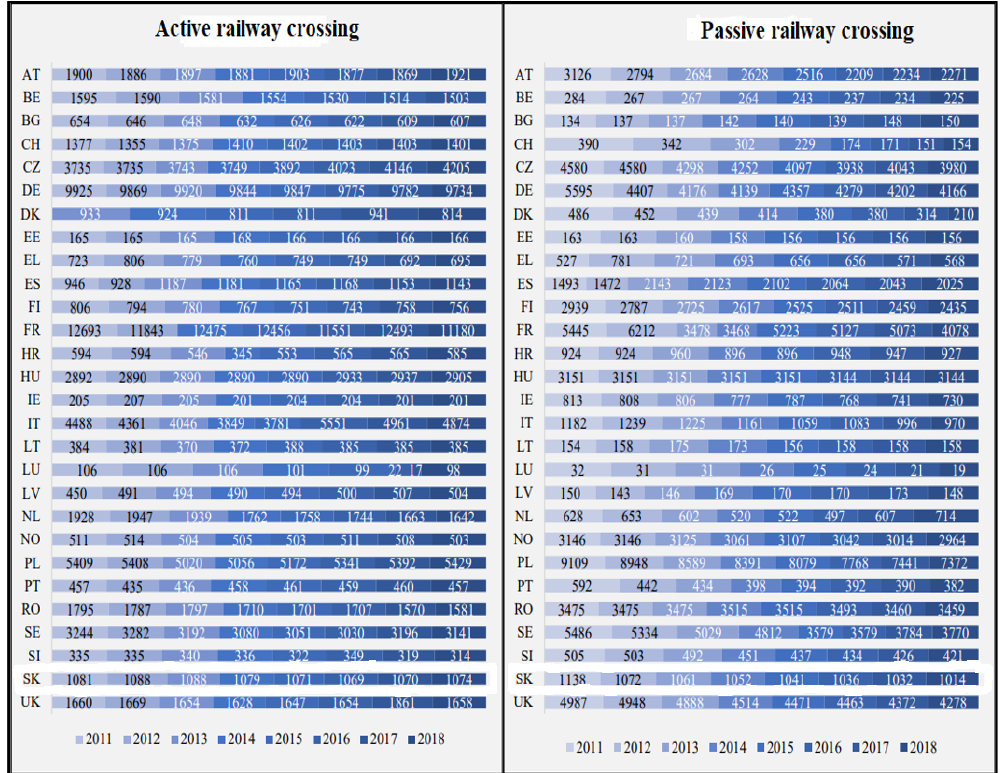
Figure 2. Percentage change in the number of rail crossings in ERA countries between 2011 and 2021 [30].